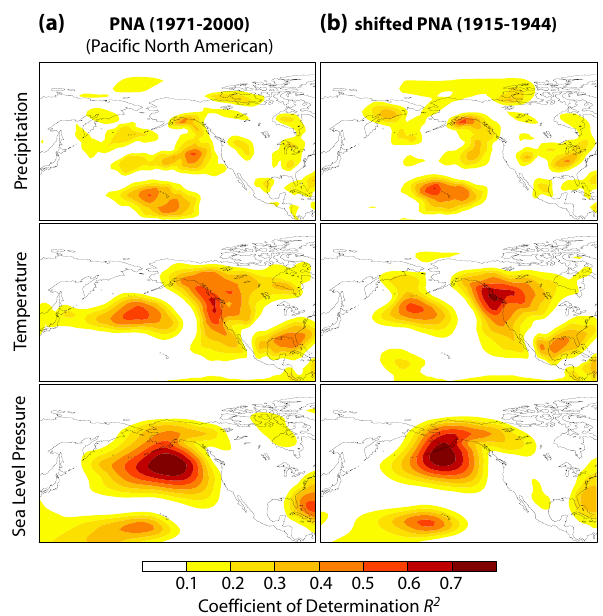
Fig. 9. As Fig. 7 but for (a) the Pacific North American pattern (PNA) and (b) the shifted